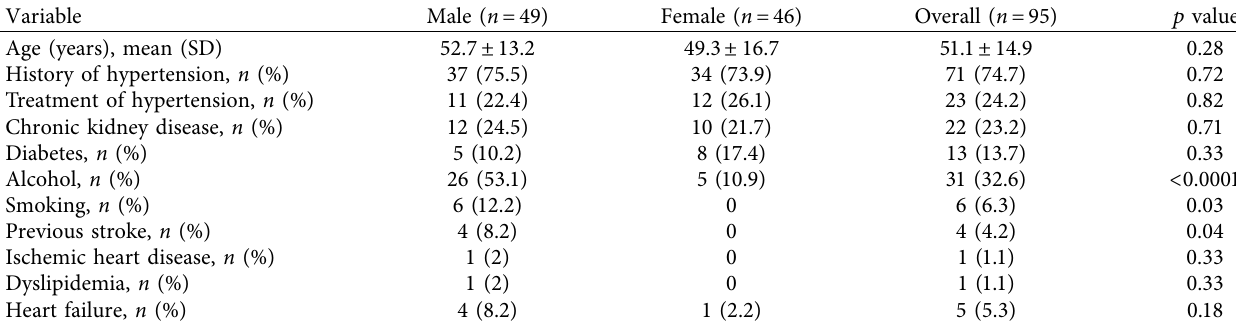
Table 1: Sociodemographic characteristics, risk factors, and comorbidities.